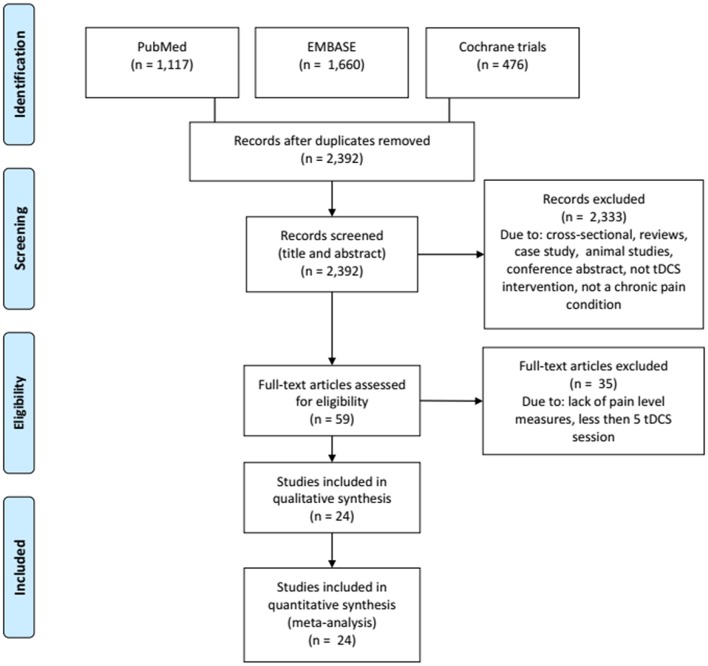
Flowchart of the systematized search.